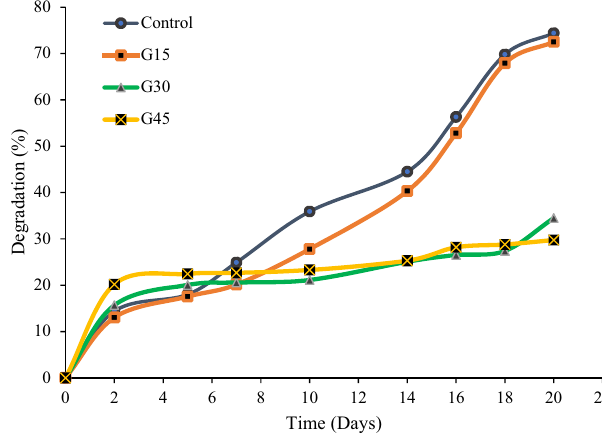
Figure 13. Degradation of control and G-plasticized AS films as a function of soil burial